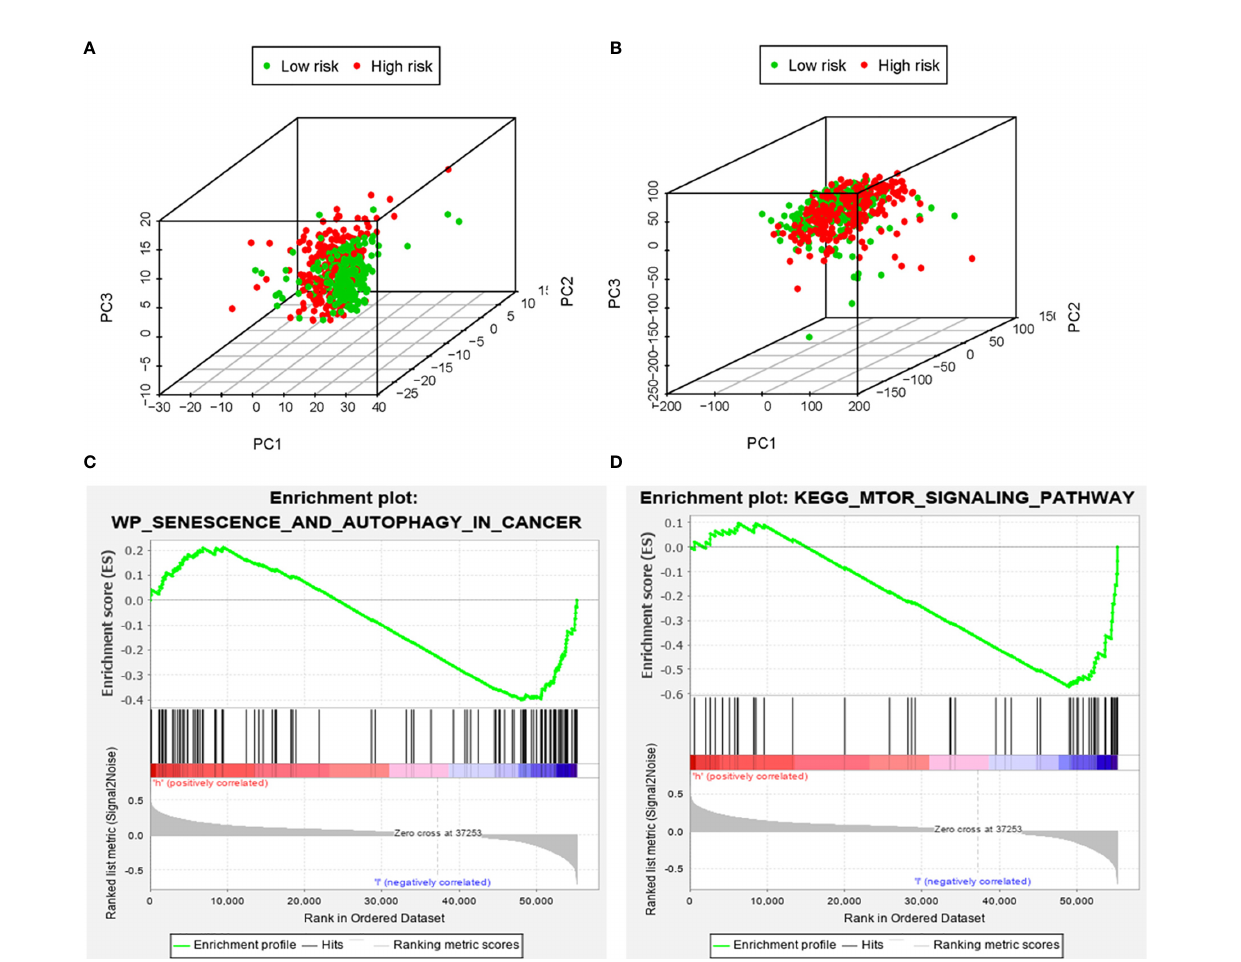
FIGURE 8 | The principal components analysis (PCA) and gene set enrichment analysis (GSEA). The high ‐ risk group and the low ‐ risk group tended to express different autophagy status. PCA among the high ‐ risk group and the low ‐ risk group based on the autophagy ‐ related gene sets (A) . PCA among the high ‐ risk group and the low ‐ risk group based on the whole protein ‐ coding gene sets (B) . GSEA implied remarkable enrichments of autophagy in cancer and autophagy-related pathway (MTOR) in the high ‐ risk group (C, D)